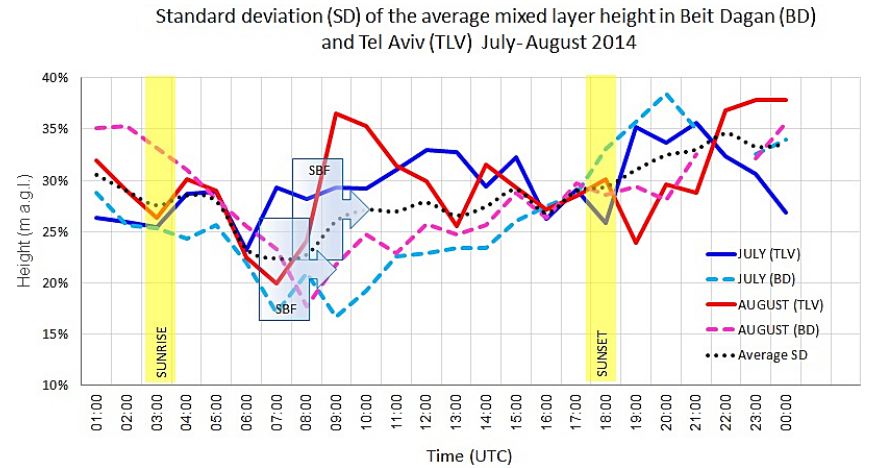
Figure 7. The standard deviation (SD) of the hourly averaged MLH, given in Fig. 6, taken over 20 days in July and 24 days in August at the TLV site, and 30 days in July and 30 days in August at the BD site. An hourly SD average from both sites (dotted black line) ranges between 22 and